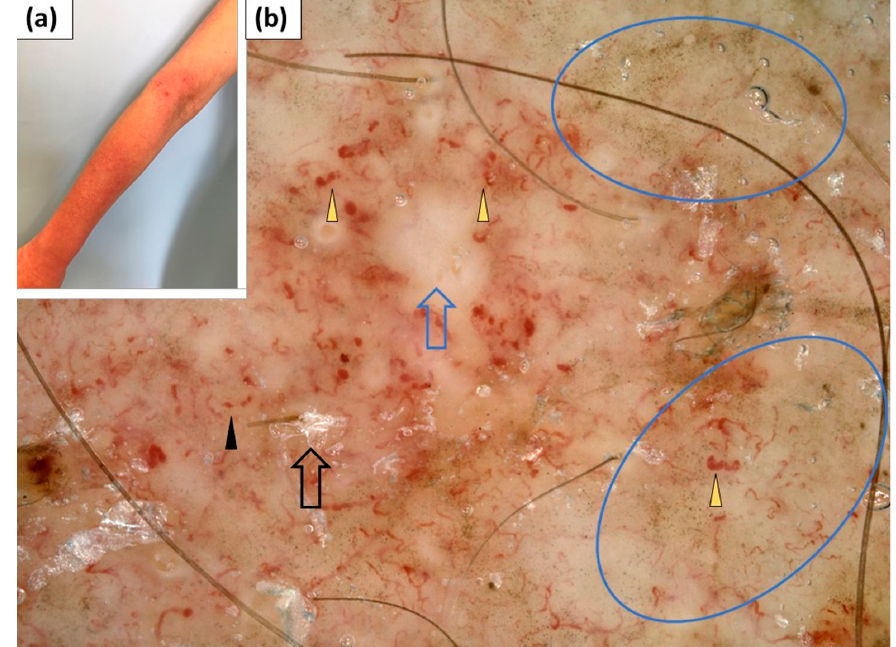
Figure 10. ( a ) Clinical presentation of erythematous lesions on the forearms. ( b ) Videodermoscopy of the lesions on the forearms showed irregularly distributed dotted vessels (black arrowhead) and linear curved vessels (yellow arrowhead), white patchy scales (black arrow), white structureless areas (blue arrow), and irregularly distributed brown-grey dots (blue